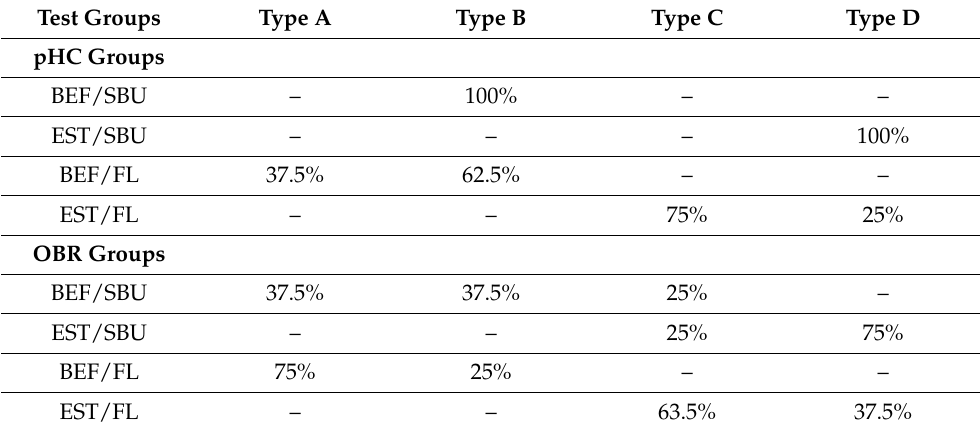
Table 3. Percentage of the artificial caries pattern.